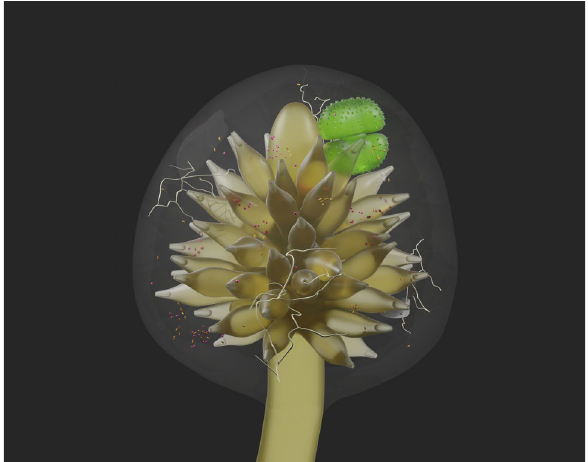
Figure 4. Model of microbial associations with the mature Takakia mucilage organ. A three-dimensional model of the mature T. lepidozioides mucilage organ illustrates its role in amplifying the production of mucilage that harbors abundant and diverse microbial associates, including bacteria, fungi, and other microeukaryotes. Microbes are also depicted as occupying mucilage within open-tipped mucilage cells. Evidence for endogenous origin of the core parenchymatous lateral axis from a rhizomatous (root-analog) axis, presence of an apical meristem (top), and intracellular location of microbes are features suggesting analogies to specialized lateral roots of angiosperms that are adapted in ways that foster beneficial microbial associations. These features also indicate that dehisced mucilage organs might be able to function as asexual reproductive structures that transmit microbial associations from one generation to the